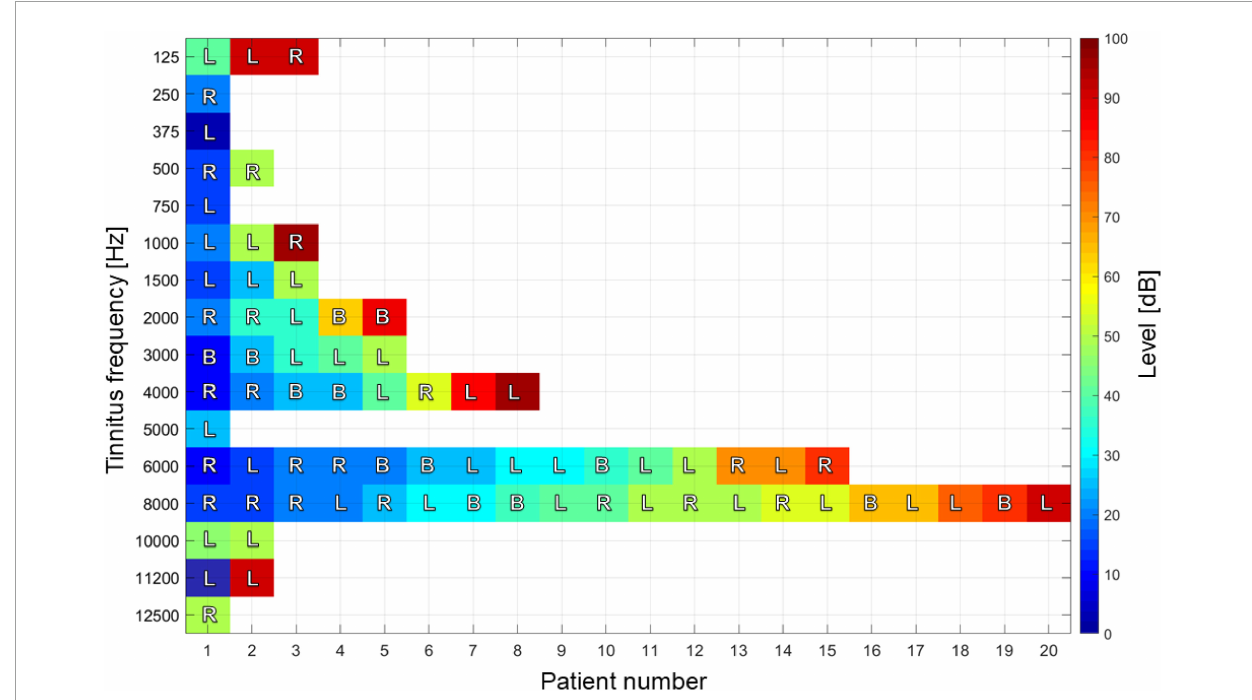
FIGURE3 Tinnitus pitch, intensity, and recurrence of the cohort of 71 tinnitus sufferers. Decibel values indicate perceived sound level: from very soft (0) to very loud (100 dB). Letters show the laterality of tinnitus, left (L), right (R) or both (B) ears.